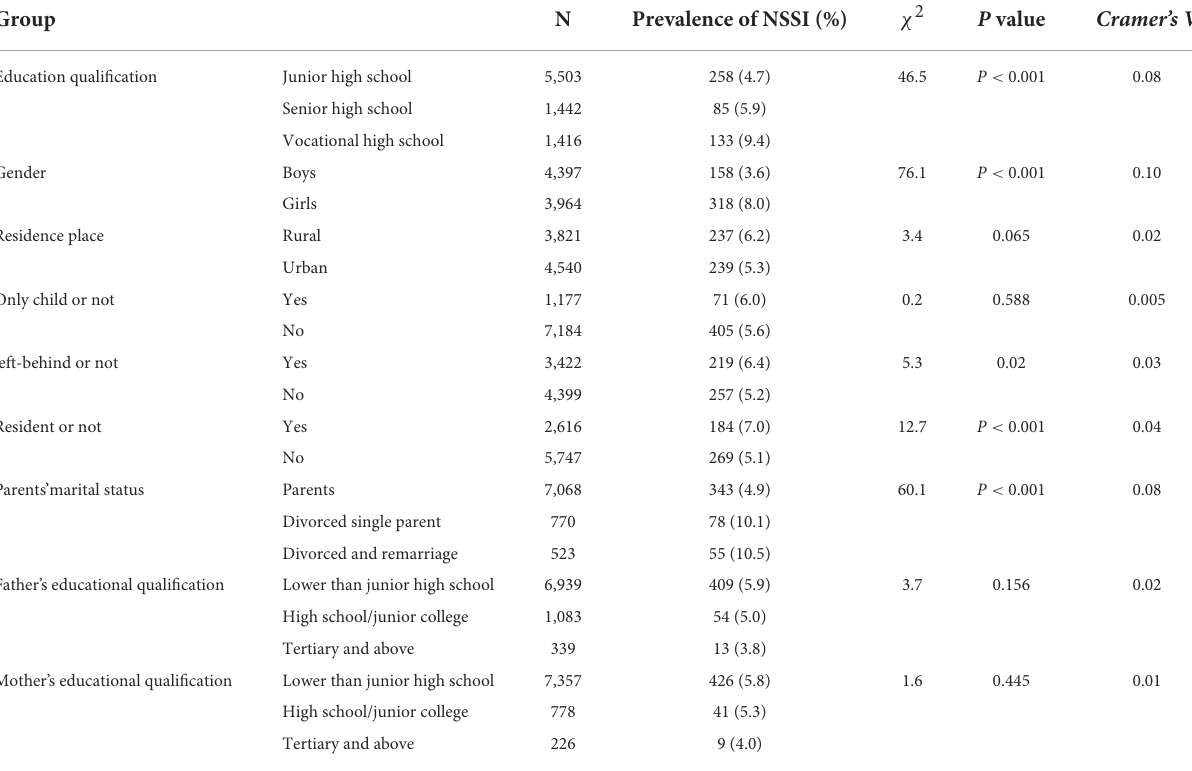
TABLE 1 Descriptive analysis of the prevalence of NSSI in the past year. Group